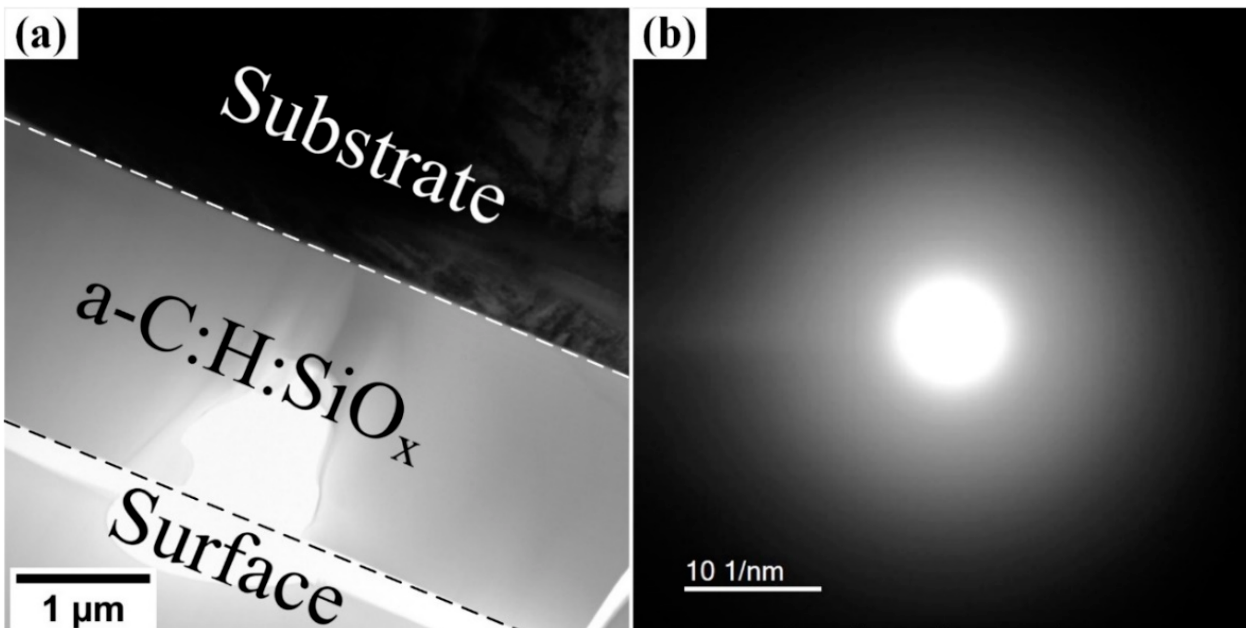
Figure 2. Cross-sectional bright-field TEM image of a-C:H:SiO x coating ( a ), NBD at the coating center ( b ).